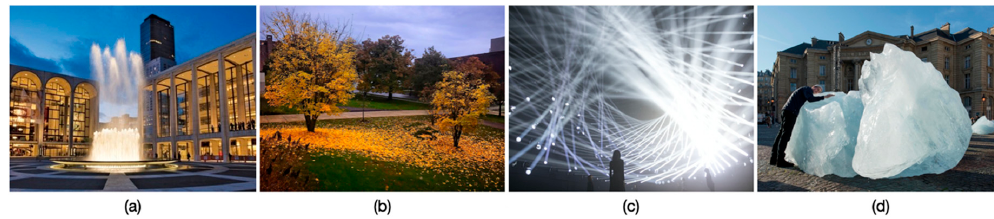
Figure 4. Examples suggested by the participants (Reprinted with permission): ( a ) Lincoln Center fountains, ( b ) leaves changing color, ( c ) TeamLab light sculpture, and ( d ) Ice Watch